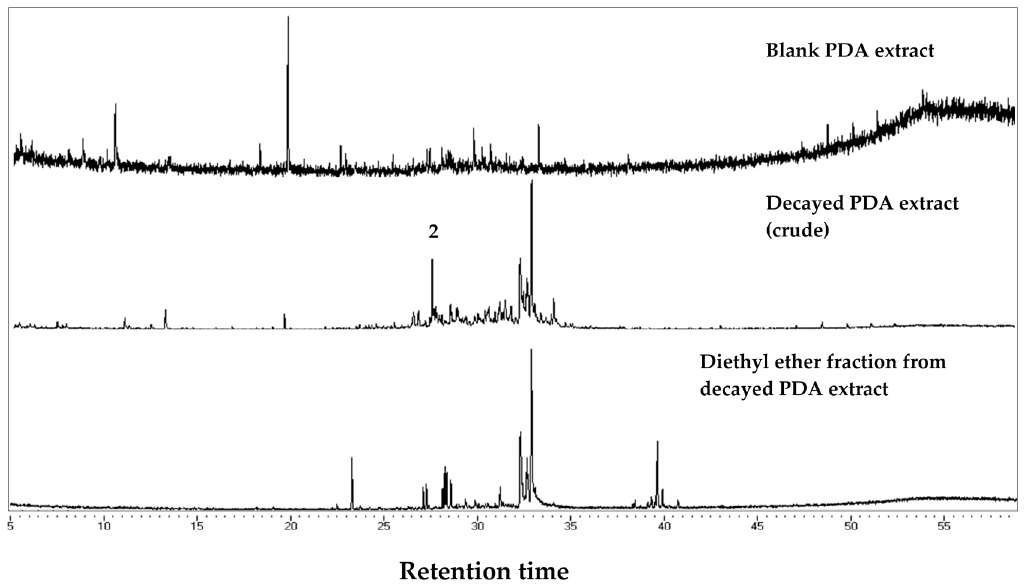
Figure 6. Chromatogram of blank, crude decayed, and diethyl ether fraction from decayed PDA extract. Peak 2 (retention time (RT) 27.72) was also present in the decayed wood extract.